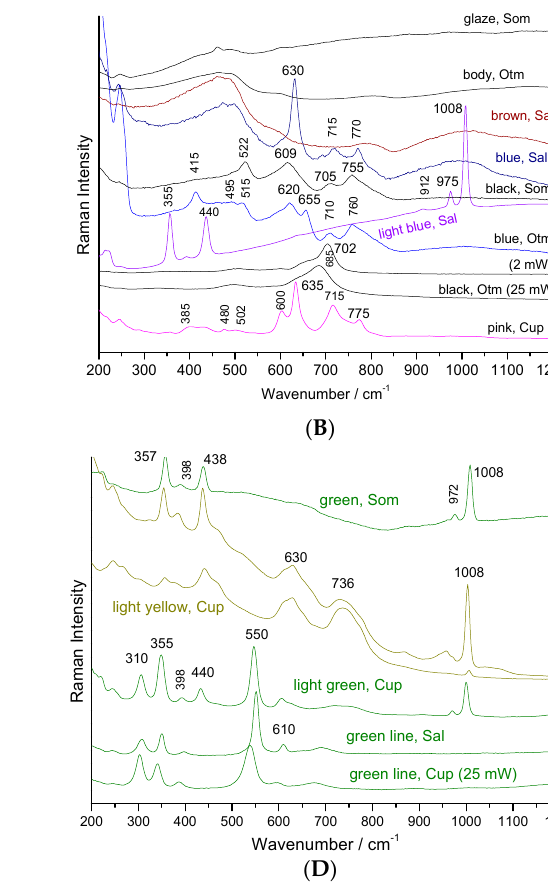
CdS 1-x Se x ; (b,c) pale yellow glaze on porcelain (Figure 3e, Somi cup); (d–g) yellow glaze on porcelain colored by addition of praseodymium and opacified by addition of cassiterite and yttrium-stabilized zirconia. A zoom of (b) and (c) pale yellow glaze in the 1800–2500 cm − 1 range is given in ( E ) (power at the sample, 5 (D0) and 0.05 (D2) mW).